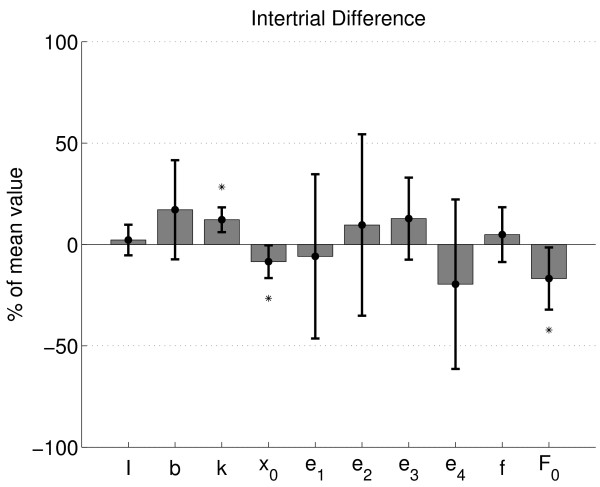
Intertrial difference. Intertrial parameter difference (solid bars: mean; error bars ± 1 s.d.) relative to the mean value of both measurements (one repetition), and then averaged over all conditions and subjects and for all parameters (horizontal axis). Asterisk denotes statistical difference from zero value.